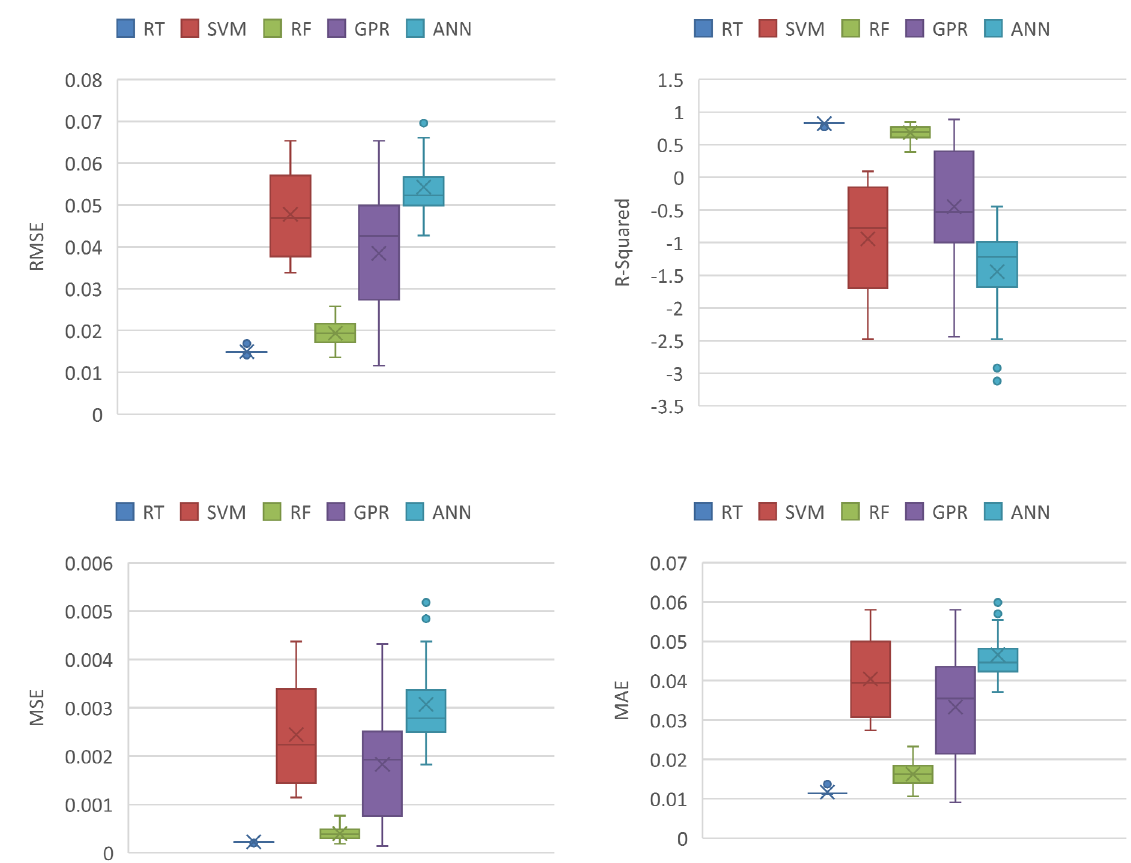
Fig. 14. Box Plot Comparisons of Methods for